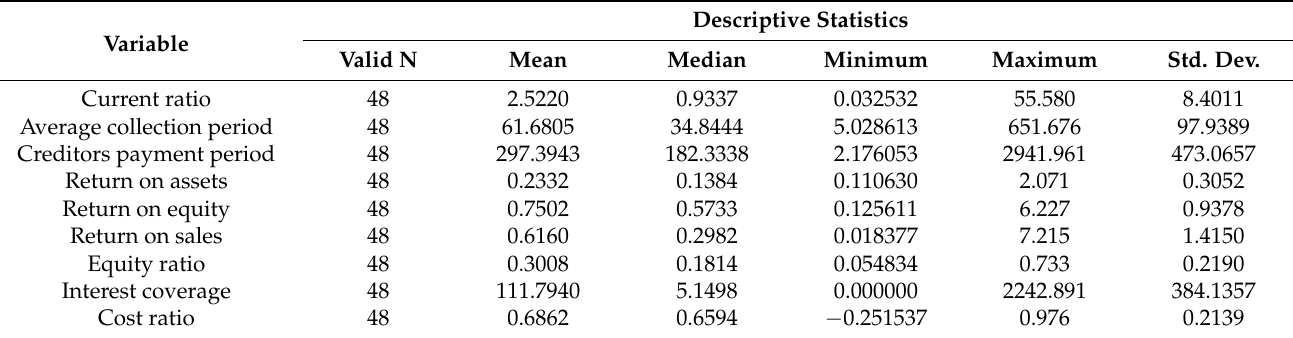
Table 1. Descriptive statistics for the analyzed